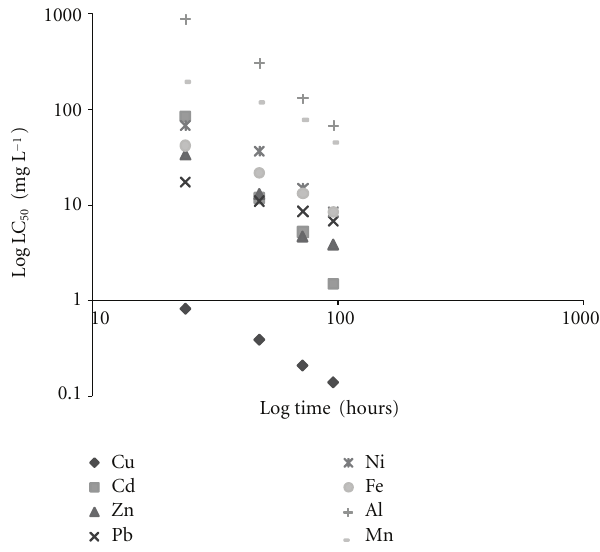
Figure 1: The relationship between median lethal concentration (LC 50 ) and exposure times for M. tuberculata .